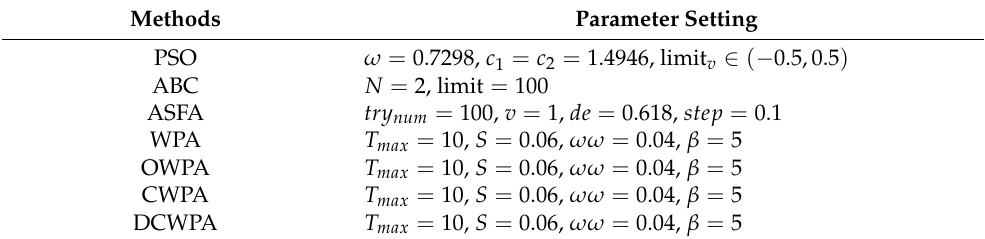
Table 4. Parameter setting of the intelligent optimization algorithms.